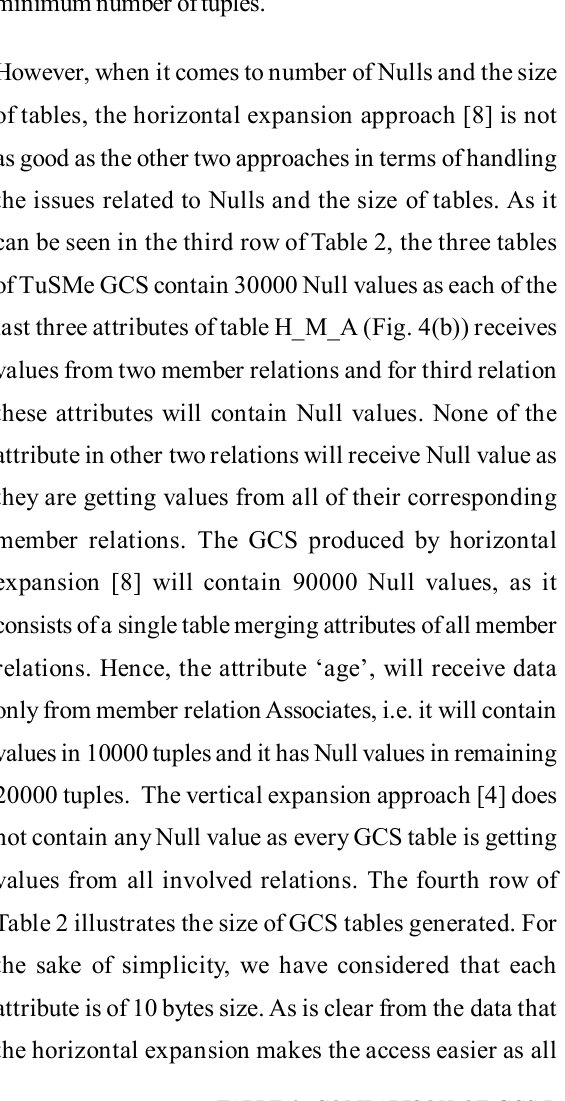
TABLE 2. COMPARISON OF GCS DATA GENERATED BY THREE